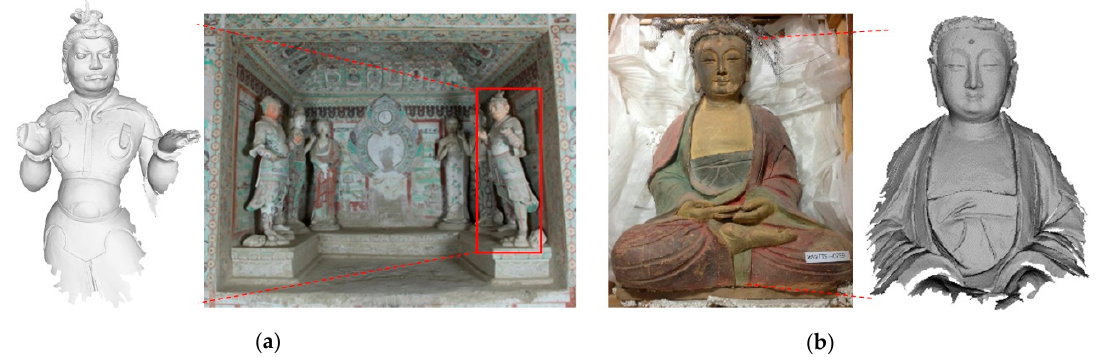
Figure 5. Illustration of General and Buddha data. ( a ) General data in Mo Kao Grotto ( b ) Buddha data from the Wuwei museum.